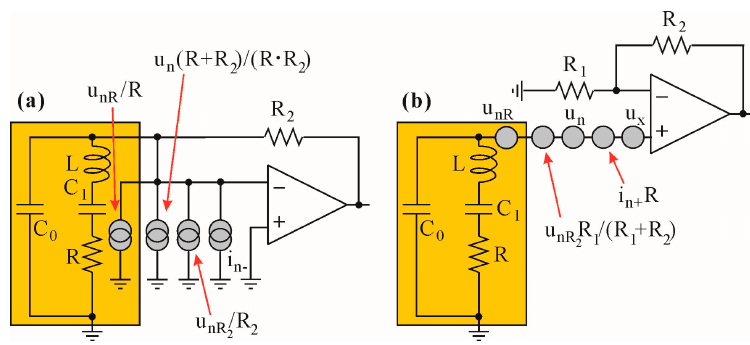
Figure 8. Circuits presented in Figure 7 with the noise sources transformed to the amplifier inputs: ( a ) transimpedance configuration; ( b ) voltage configuration.